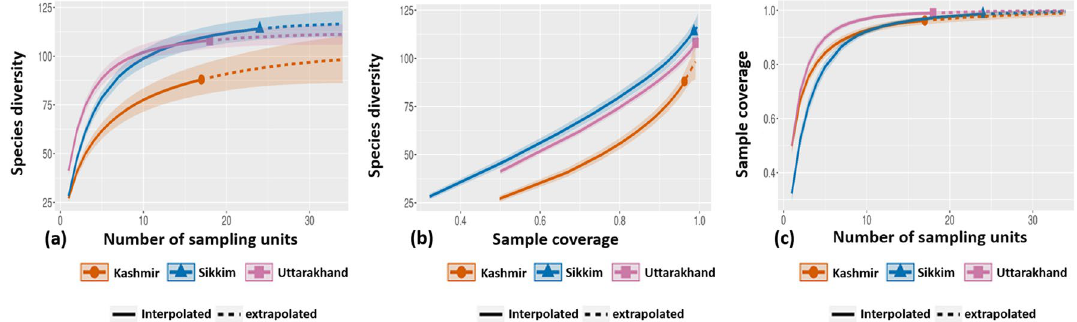
Figure 2. Species estimation curves: (a) sample-size-based rarefaction/extrapolation sampling curves (b) coverage-based rarefaction/extrapolation sampling curves and (c) sample completeness curves based on sample size and sample coverage for three elevation transects with different sample sizes (red colour—17 samples in Kashmir, purple colour—18 samples in Uttarakhand and blue colour—24 samples in Sikkim). The shaded portion in (a) represents the upper and lower bound 95% confidence intervals to the estimated richness. The cumulative number of lichen species ( y -axis) is plotted as a function of the cumulative number of samples ( x -axis) pooled in a random